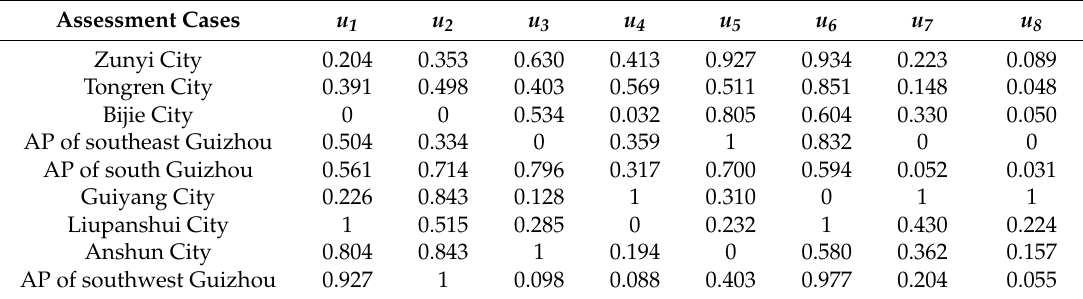
Table 8. Dimensionless data of Guizhou